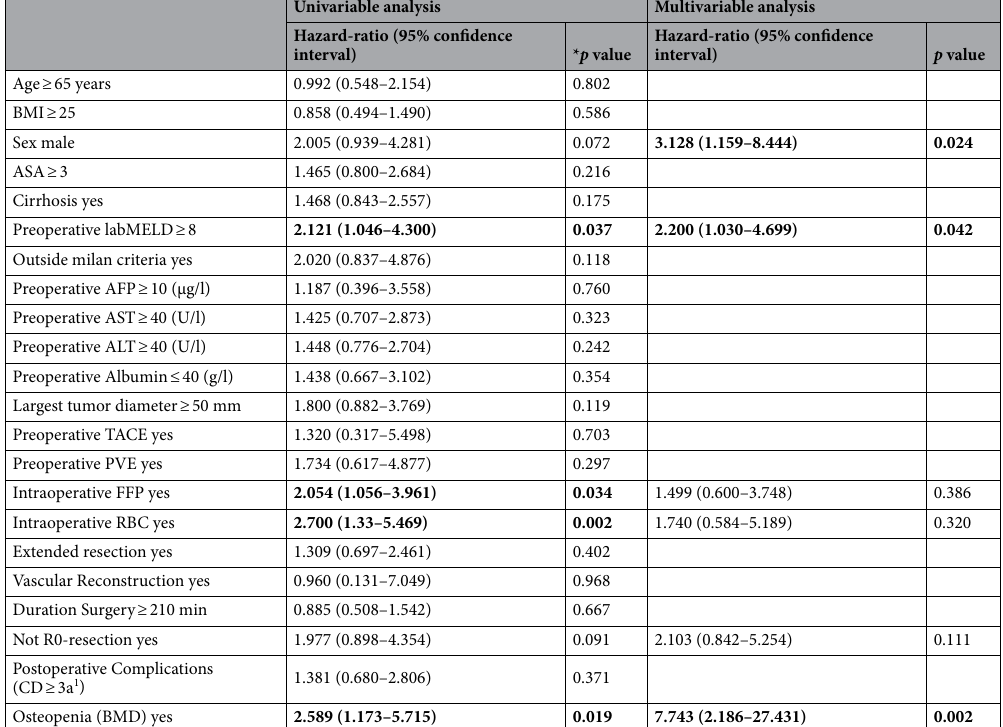
Table 4. Uni- and multivariable Cox regression analysis for overall survival. Results of the Cox regression analysis were given as Hazard-ratios with 95% confidence interval. 1 Refers to Clavien et al. 26 . BMI Body mass index; ASA American Society of Anesthesiologists; MELD model for end-stage liver disease; AFP alphafetoprotein; AST Aspartate aminotransferase; ALT Alanine aminotransferase; TACE Transarterial chemoembolization; PVE Portal venous embolization; FFP Fresh frozen plasma; RBC Red blood cell unit; CD Clavien-Dindo classification; BMD Bone mineral density. Significant values are in